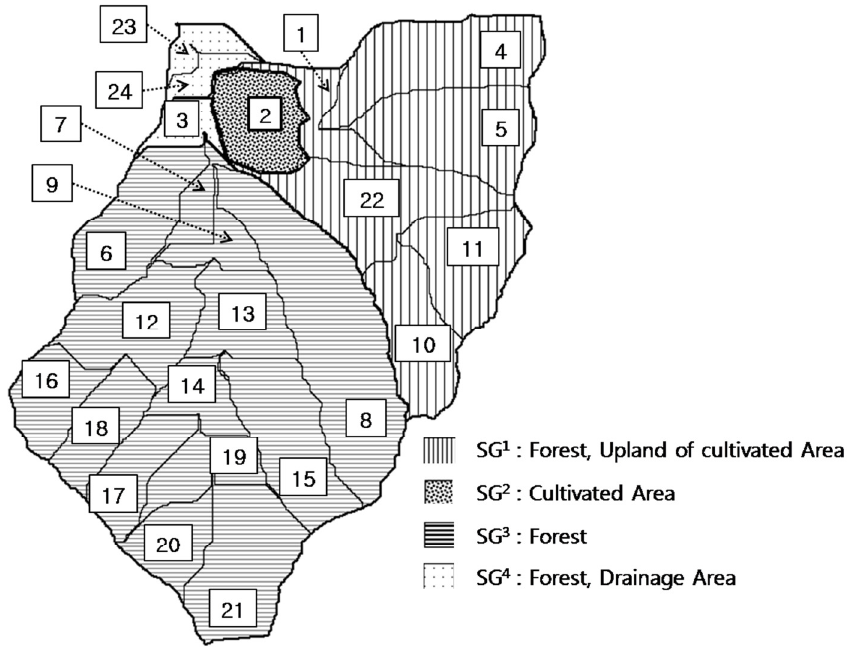
Figure 11. Twenty-four Subwatersheds and Four Subwatersheds Groups for Diversion Channel